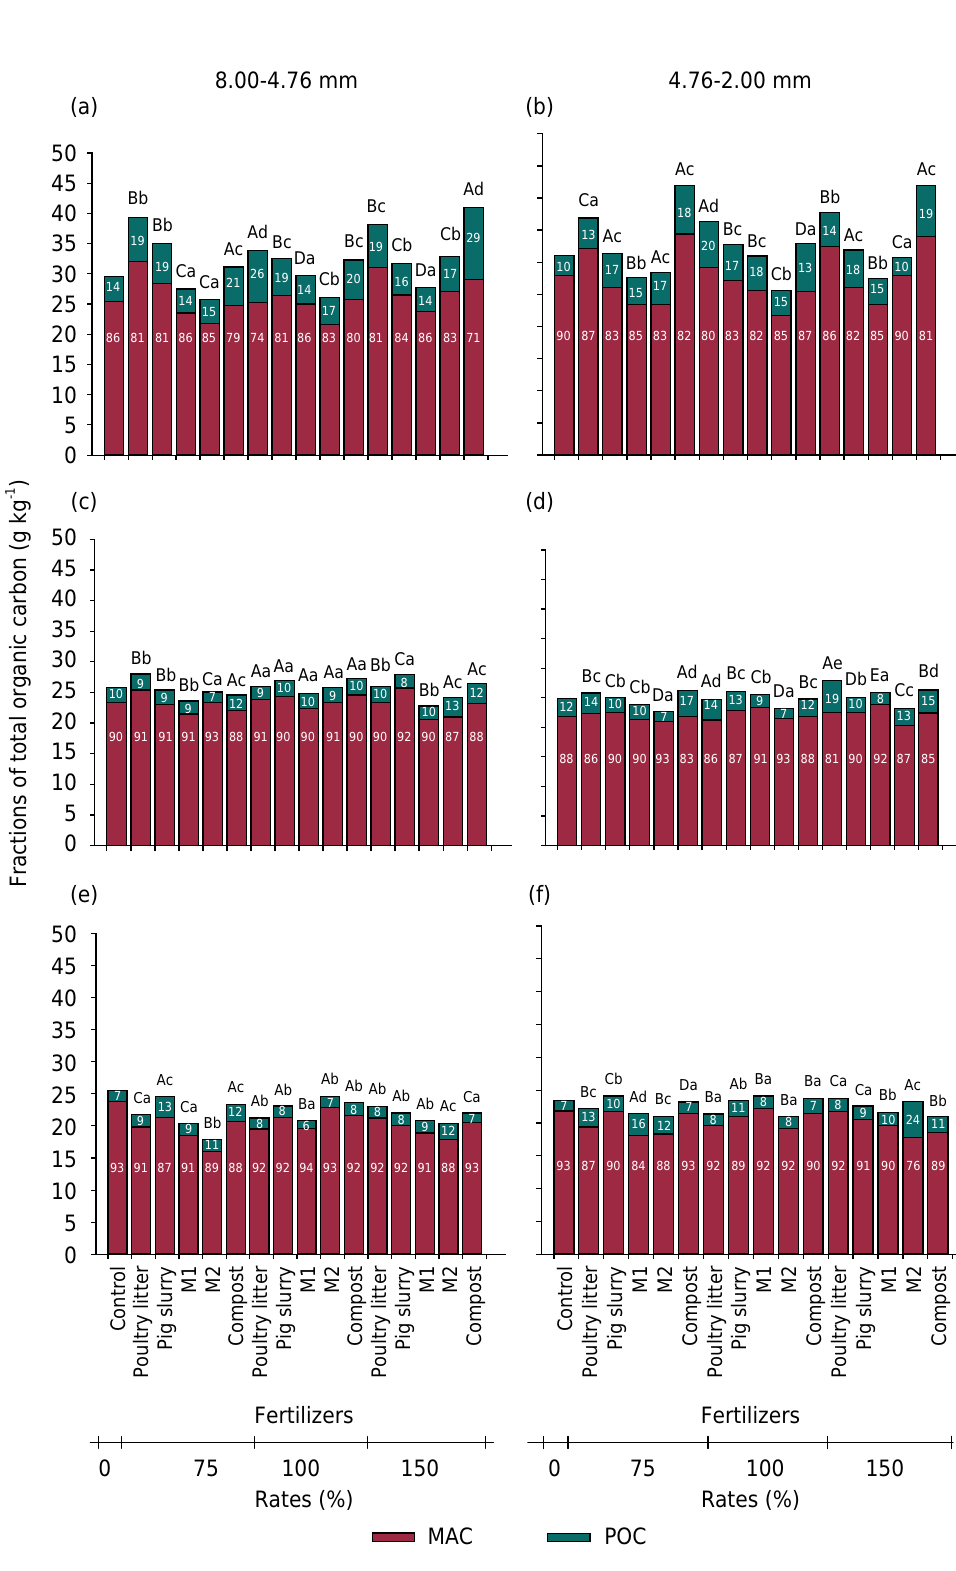
Figure 7. Proportion of fractions of total organic carbon (g kg -1 ) (MAC in wine red and POC in grey) in the size aggregates of 8-4.76 mm and 4.76-2 mm in response to the application of organic and mineral fertilizers in a Rhodic Kandiudox. (a,b) 0.00-0.05 m soil layer; (c,d) 0.05-0.10 m soil layer; and (e,f) 0.10-0.20 m soil layer. M1: mineral fertilizer 1, equivalent to pig slurry; M2: mineral fertilizer 2, equivalent to poultry litter. Uppercase letter compares the POC fractions and lowercase letter compare the MAC fractions. Through the Tukey